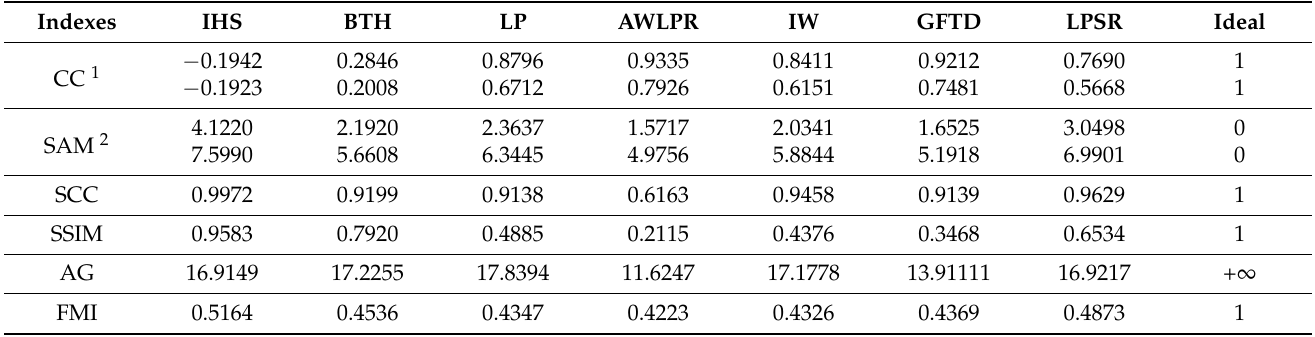
Table 3. Quantitative evaluation results of different fusion methods in area